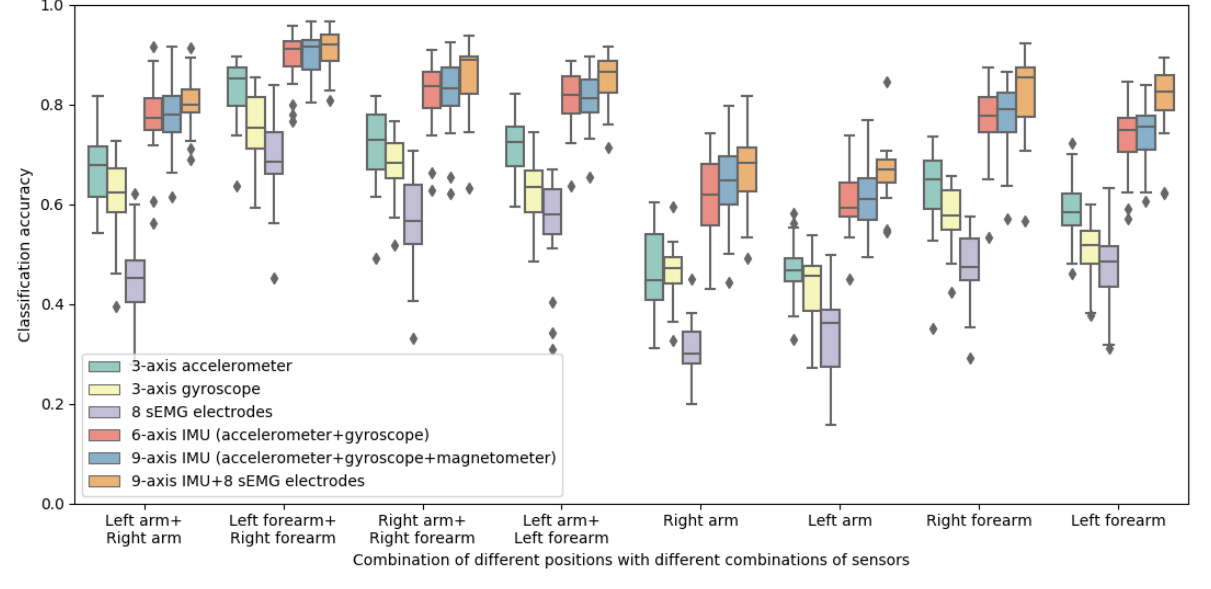
Figure 11. Classification accuracy of the user-independent model for different combinations of sensors and different placement. IMU: inertial measurement unit; sEMG: surface